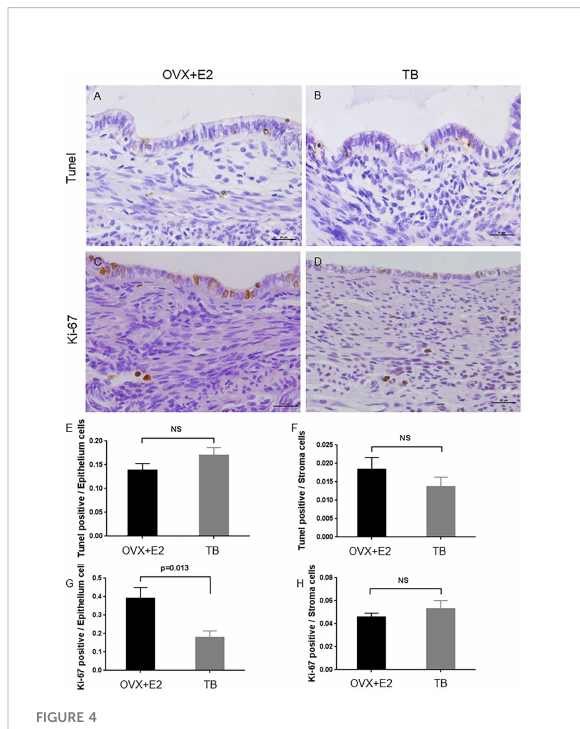
FIGURE 4 Representative images of TUNEL assay and Ki-67-stained sections of endometriotic lesions from mouse model of endometriosis at 2 months post-induction. OVX+E2, ovariectomy with estrogen supplement group; TB, male urine- soaked transfer bedding group. (A) TUNEL assay of endometriotic lesion from OVX+E2 group. (B) TUNEL assay of endometriotic lesion from TB group. (C) Ki-67 staining of endometriotic lesion from OVX+E2 group. (D) Ki-67 staining of endometriotic lesion from TB group. Scale bar, 25 m m. (E) TUNEL-positive cells per epithelium cells. (F) TUNEL-positive cells per stroma cells. (G) Ki-67-positive cells per epithelium cells. (H) Ki-67-positive cells per stroma cells. Data are shown as mean ± SEM of the ratios, n = 8, for each group. Statistics by independent t-test. NS, no signi fi